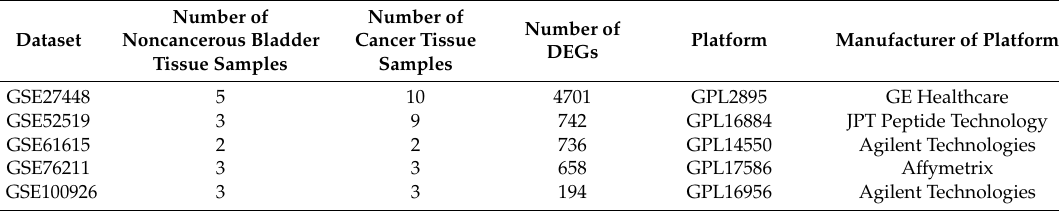
Table 1. General information on GEO datasets and